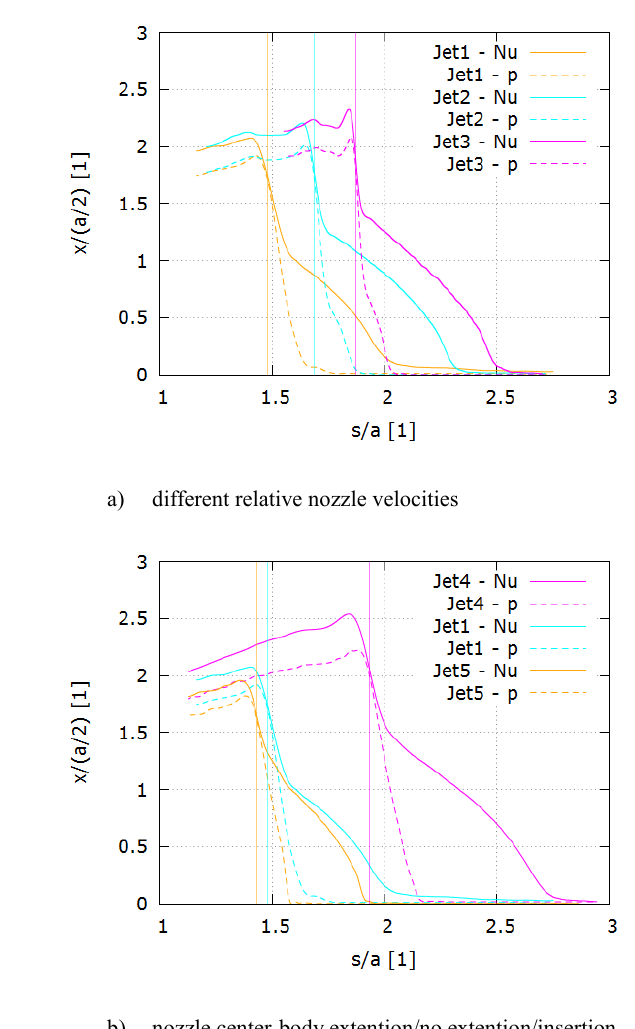
Fig. 5. Maximum heat transfer coefficient